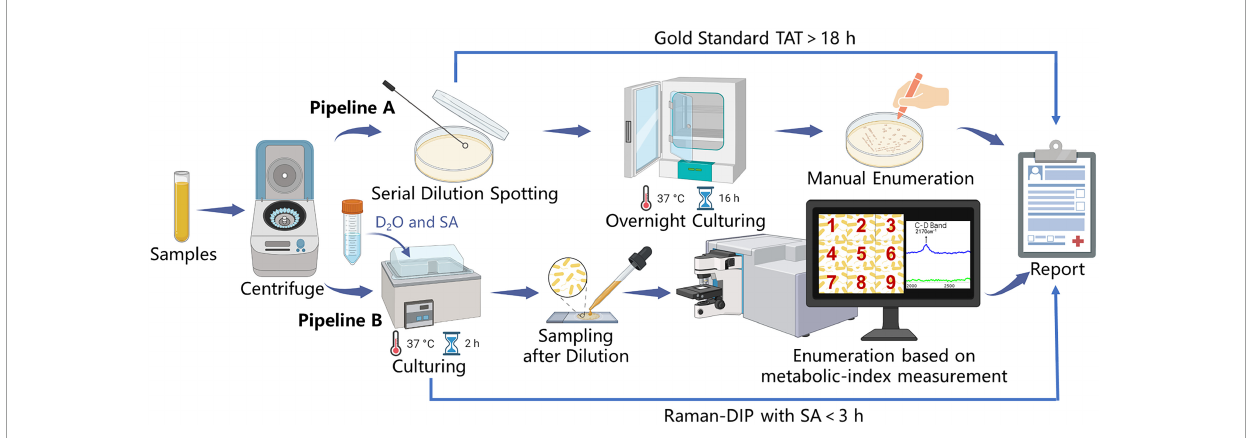
FIGURE4 Pipelines for UTI diagnosis and comparison of the Raman-DIP method versus conventional gold-standard method. Pipeline A: manual enumeration by the conventional gold standard. Pipeline B: enumeration based on metabolic-index measurement by Raman-DIP combined with SA-containing